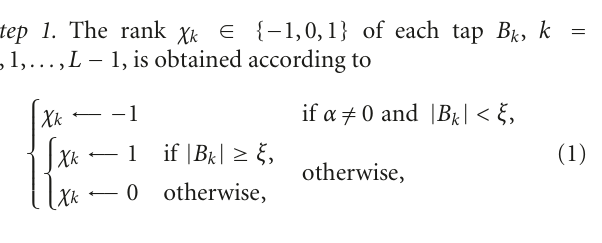
Algorithm 2 (DTA procedure). Tap Ranking and Dynamic Allocation